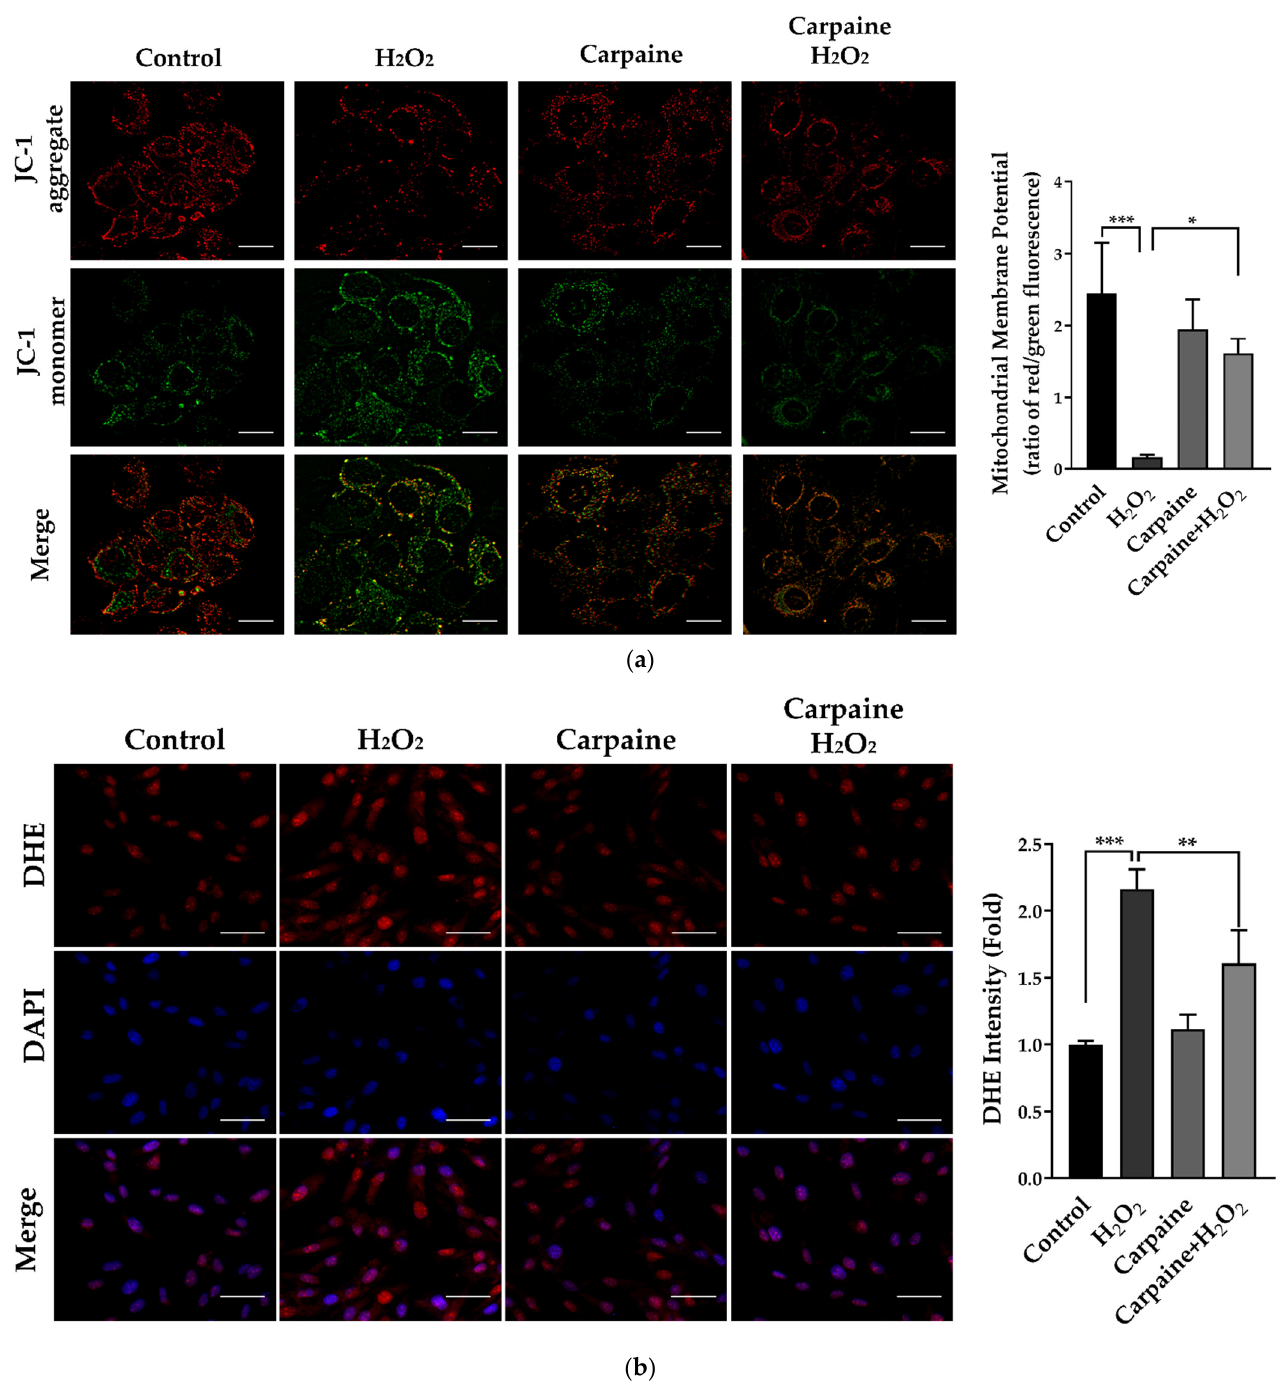
Figure 4. Carpaine provides protection against H 2 O 2 -induced IRI and oxidative stress in H9c2 cells. H9c2 were pre-treated with or without 1 µM carpaine for 1 h, followed by treatment with or without H 2 O 2 (500 µM) for 1 h. ( a ) Representative mitochondrial membrane potential images ( upper ) and quantitative red to green fluorescent ratio ( lower ), determined using a JC-1 probe. Scale bar: 20 µm. ( b ) Representative dihydroethidium (DHE) fluorescence images ( left ) and semiquantitative results of the average DHE fluorescence intensity ( right ) in H9c2 cells. Scale bar: 50 µm. The data are shown as the means ± SEM ( n = 3). * p < 0.05, ** p < 0.01, *** p < 0.001, significantly different, as indicated by a two-way ANOVA with Tukey’s comparison test.